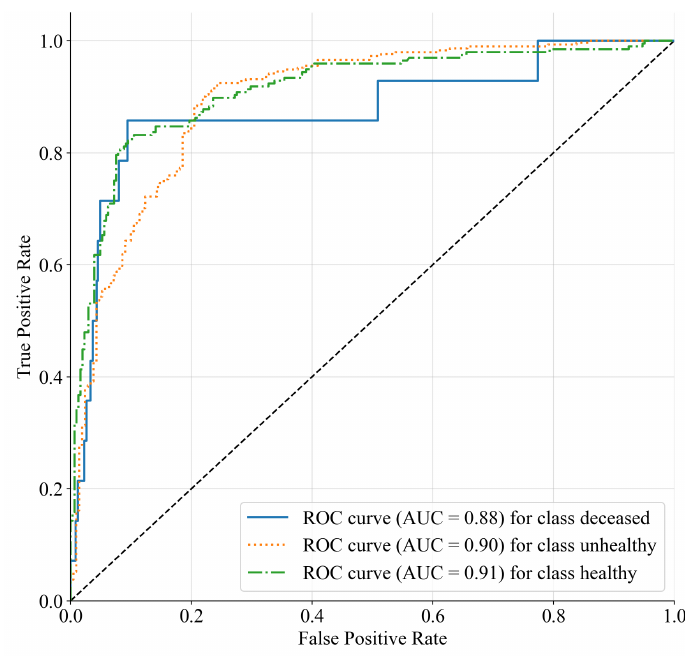
Figure 5. ROC curves that show the system performance for each class (e.g., discharge diagnosis: deceased, unhealthy, and healthy). The diagonal dashed line represents a random classifier that does not consider any information to make